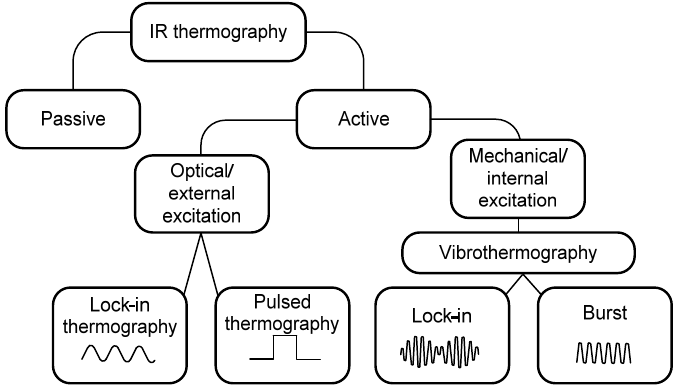
Figure 8. Classification of active thermography.